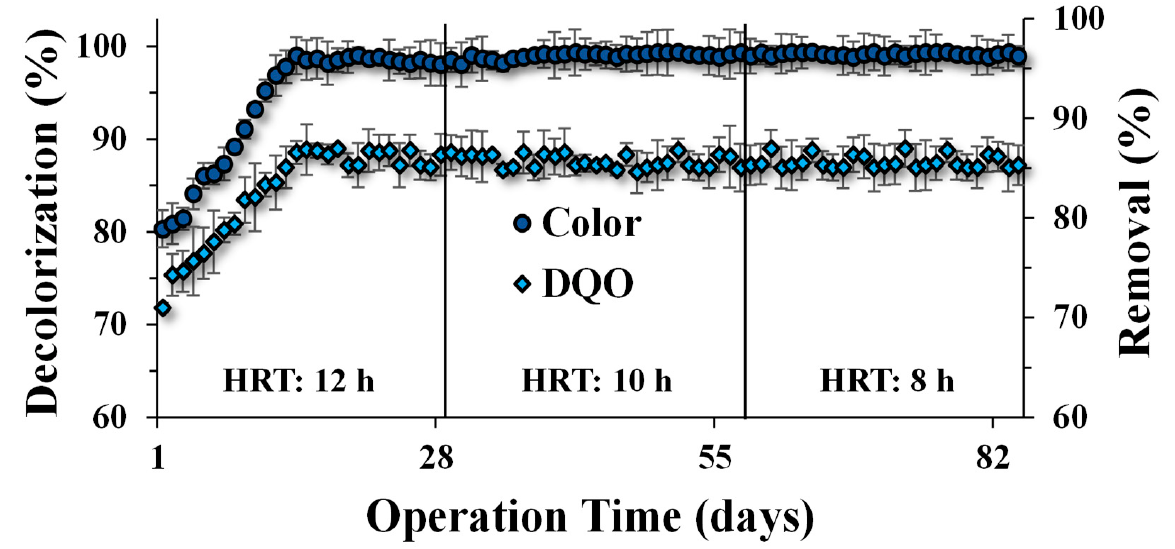
Figure 2. COD removal and CR decolorization (%) in the UASB reactor, after 12 weeks (84 days) of operation at different hydraulic residence times: 12 h, 10 h, and 8 h.